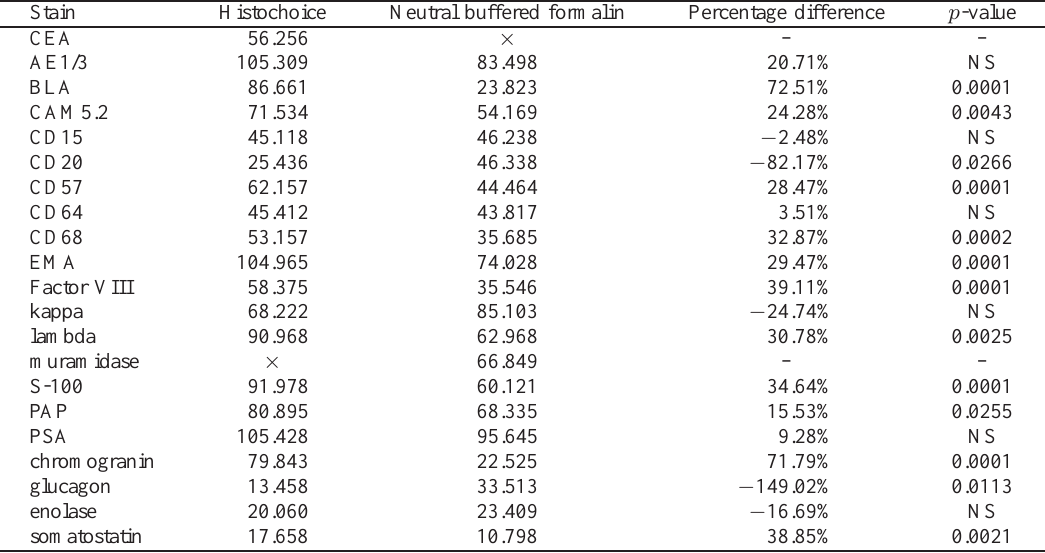
Table 3 Quantitative analysis of saturation for histochoice and formalin fixed